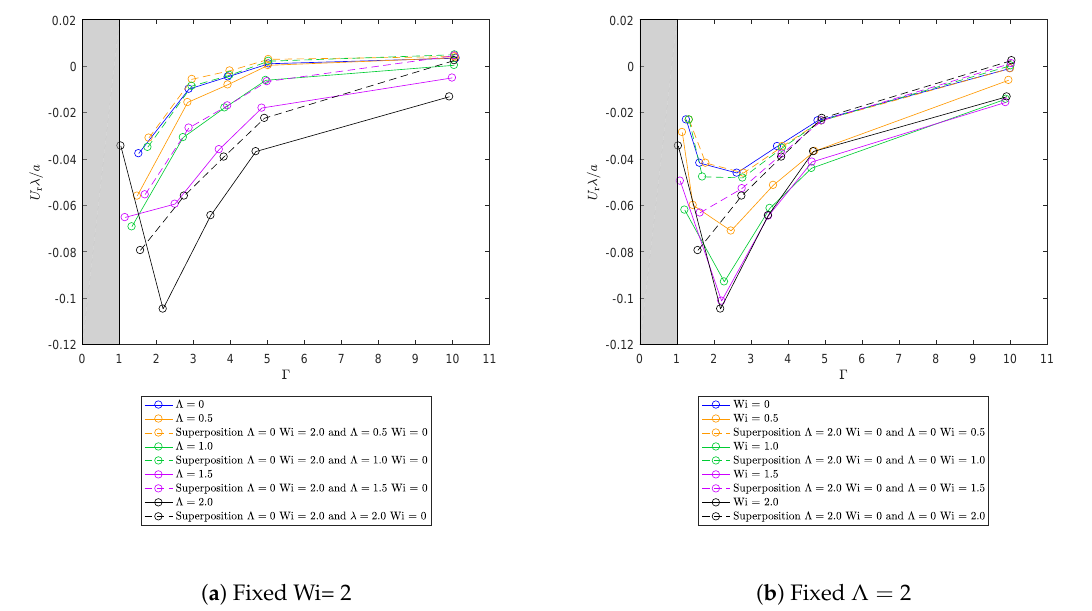
Figure 8. Migration velocity of a particle placed at different initial positions from the inner cylinder with combined complex flows (solid lines) and the superposition of the two separate flows (dashed lines) at time t / λ = 10. The shaded area indicates the inaccessible region.